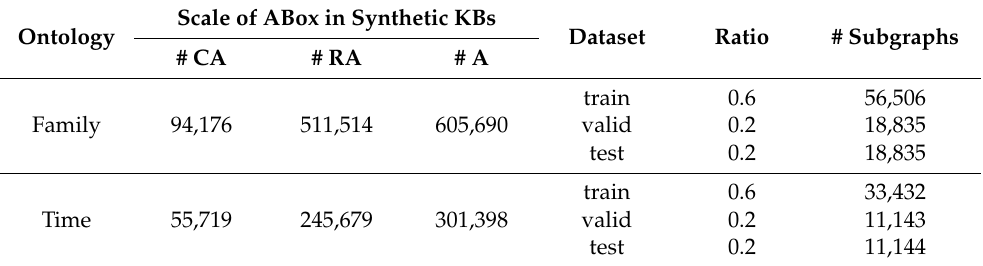
Table 2. Statistical information of ABox and dataset split in synthetic OWL DL KBs.